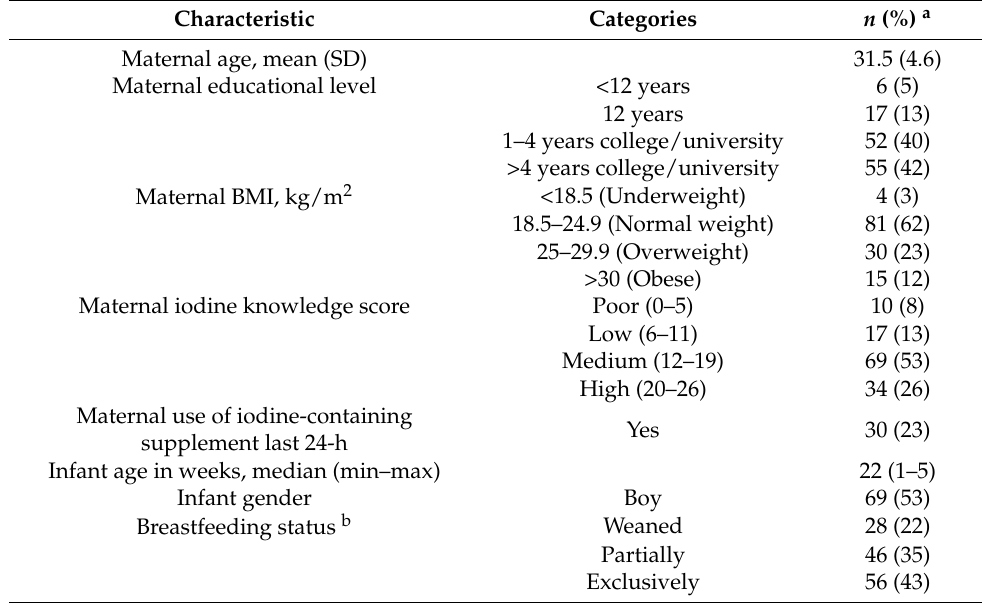
Table 1. Characteristics of mother–infant dyads ( n = 130).